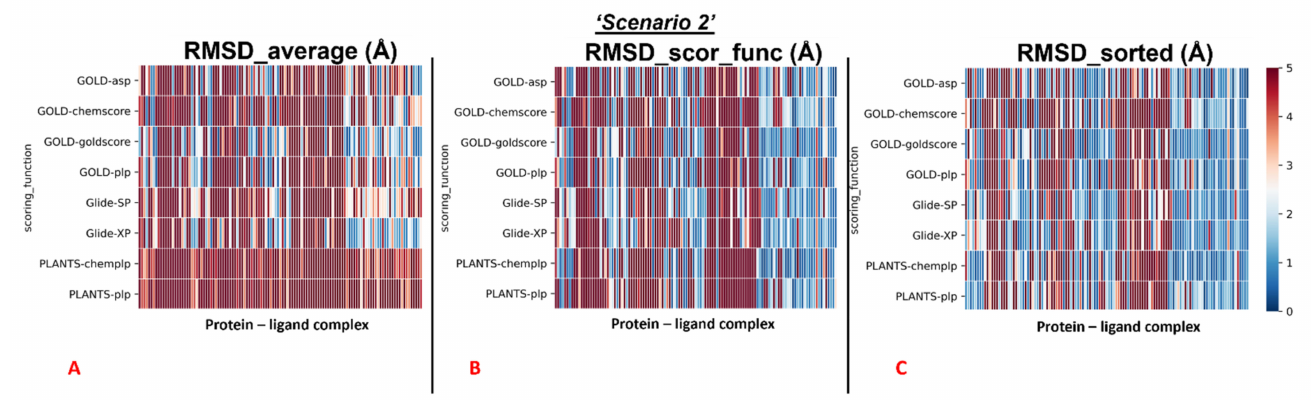
Figure 6. Colormaps represent the results of the self-docking experiments in the case in which the crystallographic water molecules at 5 Å or nearer to the ligand itself are taken into account during the docking runs. ( A ) Results coming from the average of the RMSDs of all the poses for each docking run. ( B ) Results derived just from the RMSD between the crystallographic ligand coordinates and the pose classified as the best from the scoring function.( C )Results of the self-docking experiments if just the pose showing the best RMSD value between its coordinates and the crystallographic ones is retained. The x -axis lists all the different protein–ligand complexes, which are plotted against the different pairs docking program-scoring function used for this study, reported in the y